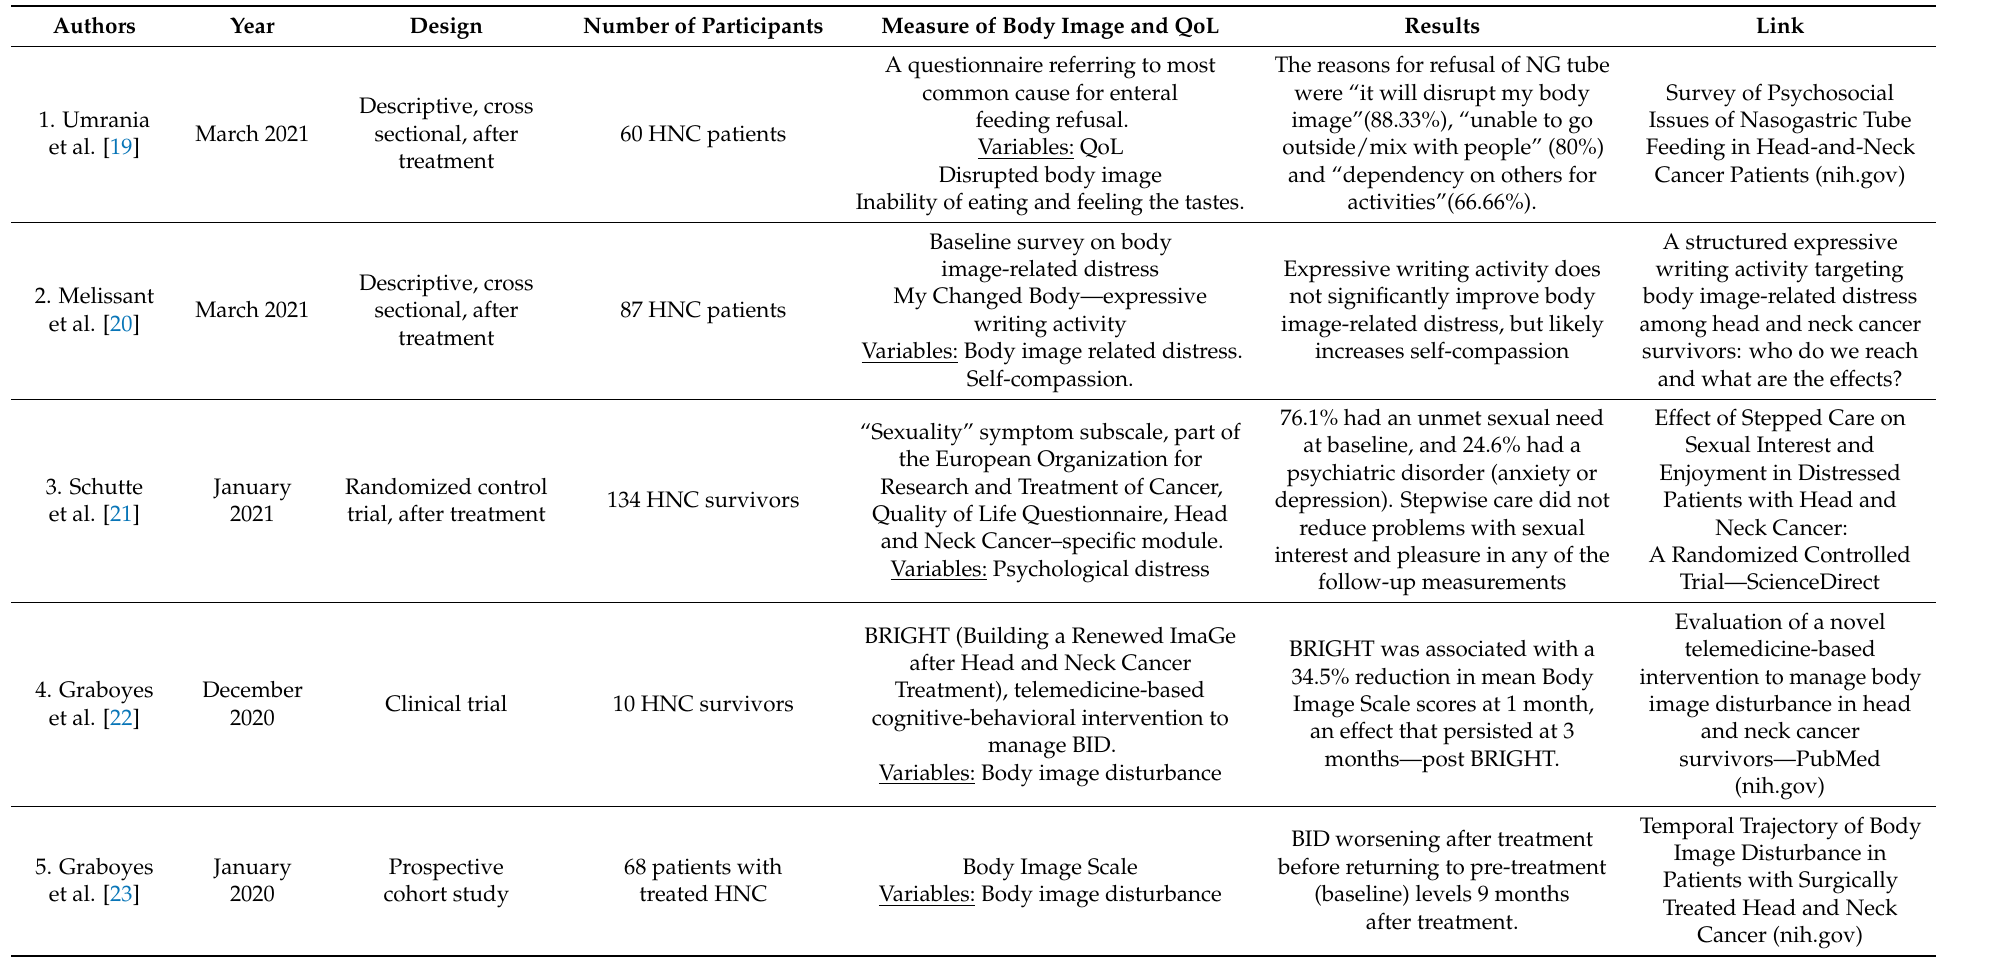
Table 2. Characteristics of the included